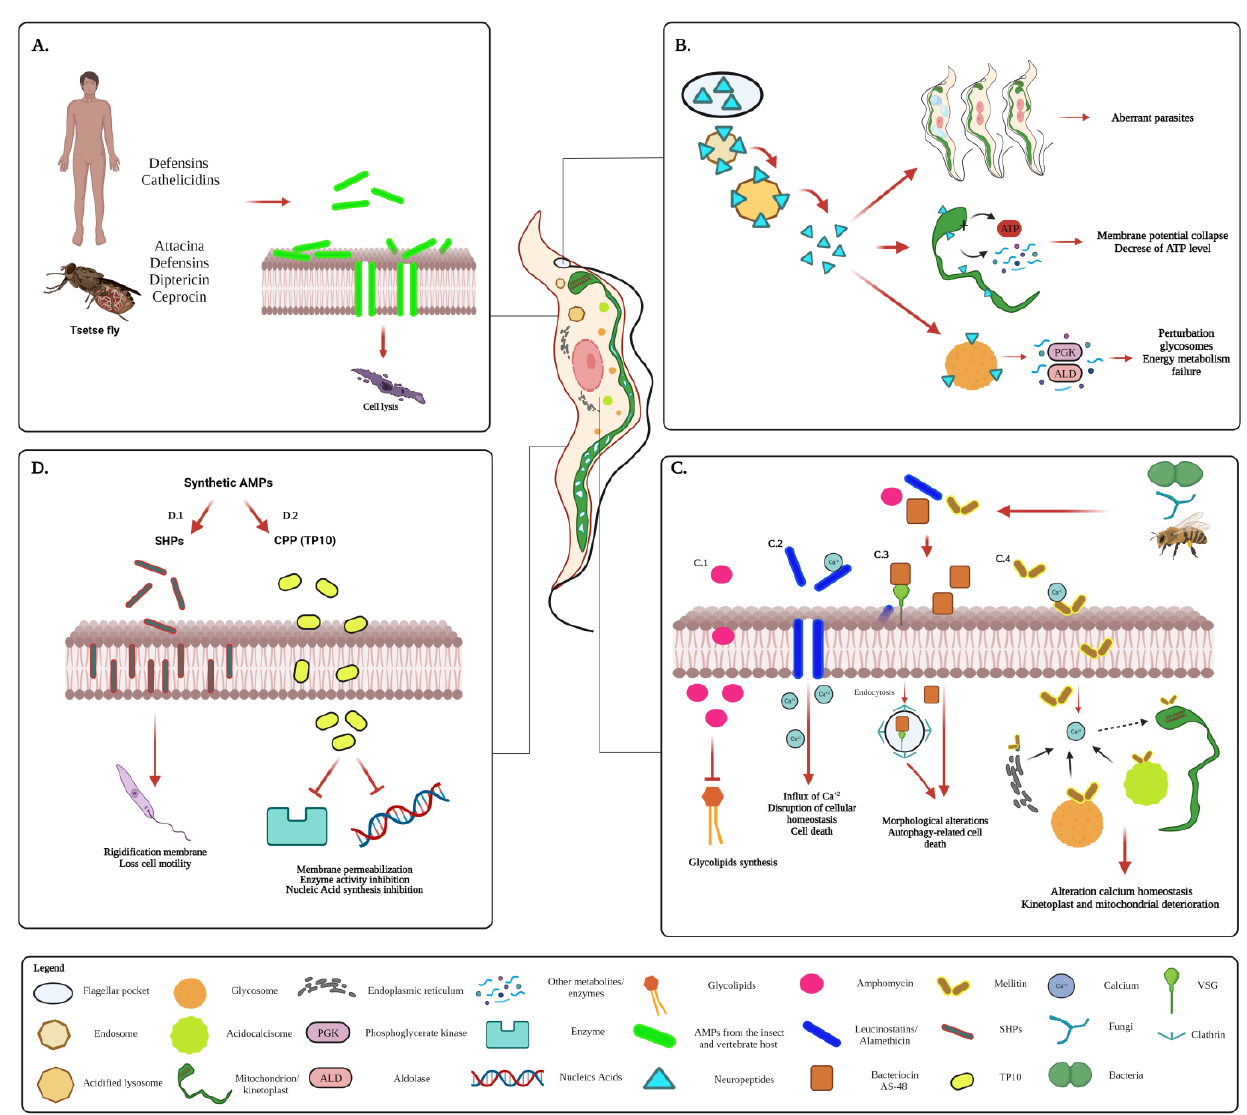
Figure 3. Mechanisms of action of antimicrobial peptides (AMPs) against T. brucei. ( A ). AMPs derived from the vertebrate host and insect vector. Peptides isolated from both vectors and hosts exert their trypanocidal effect through membrane perturbation and induction of cell lysis. ( B ). Mechanism of action of neuropeptides (NPs). The killing of trypanosomes by NPs requires the NPs to be endocytosed through the flagellar pocket and transported from the endosomes to the acidified lysosome, where they break the lysosomal bilayer membrane and accumulate in the cytoplasm. Once in the cytoplasm, their interference in various cellular processes contributes to morphological alterations and disturbance of organelles (glycosomes and mitochondrion), which ultimately lead to depletion of ATP and failure of the energy metabolism. ( C ). AMPs isolated from natural sources (bacteria, fungi, and insects). (C.1,C.2). AMPs derived from fungi. The lipopeptide amphomycin, inhibits the biosynthesis of the glycolipid precursor of glycosylphosphatidylinositol (GPI) by which the variant surface glycoproteins (VSGs) are anchored to the plasma membrane of these parasites